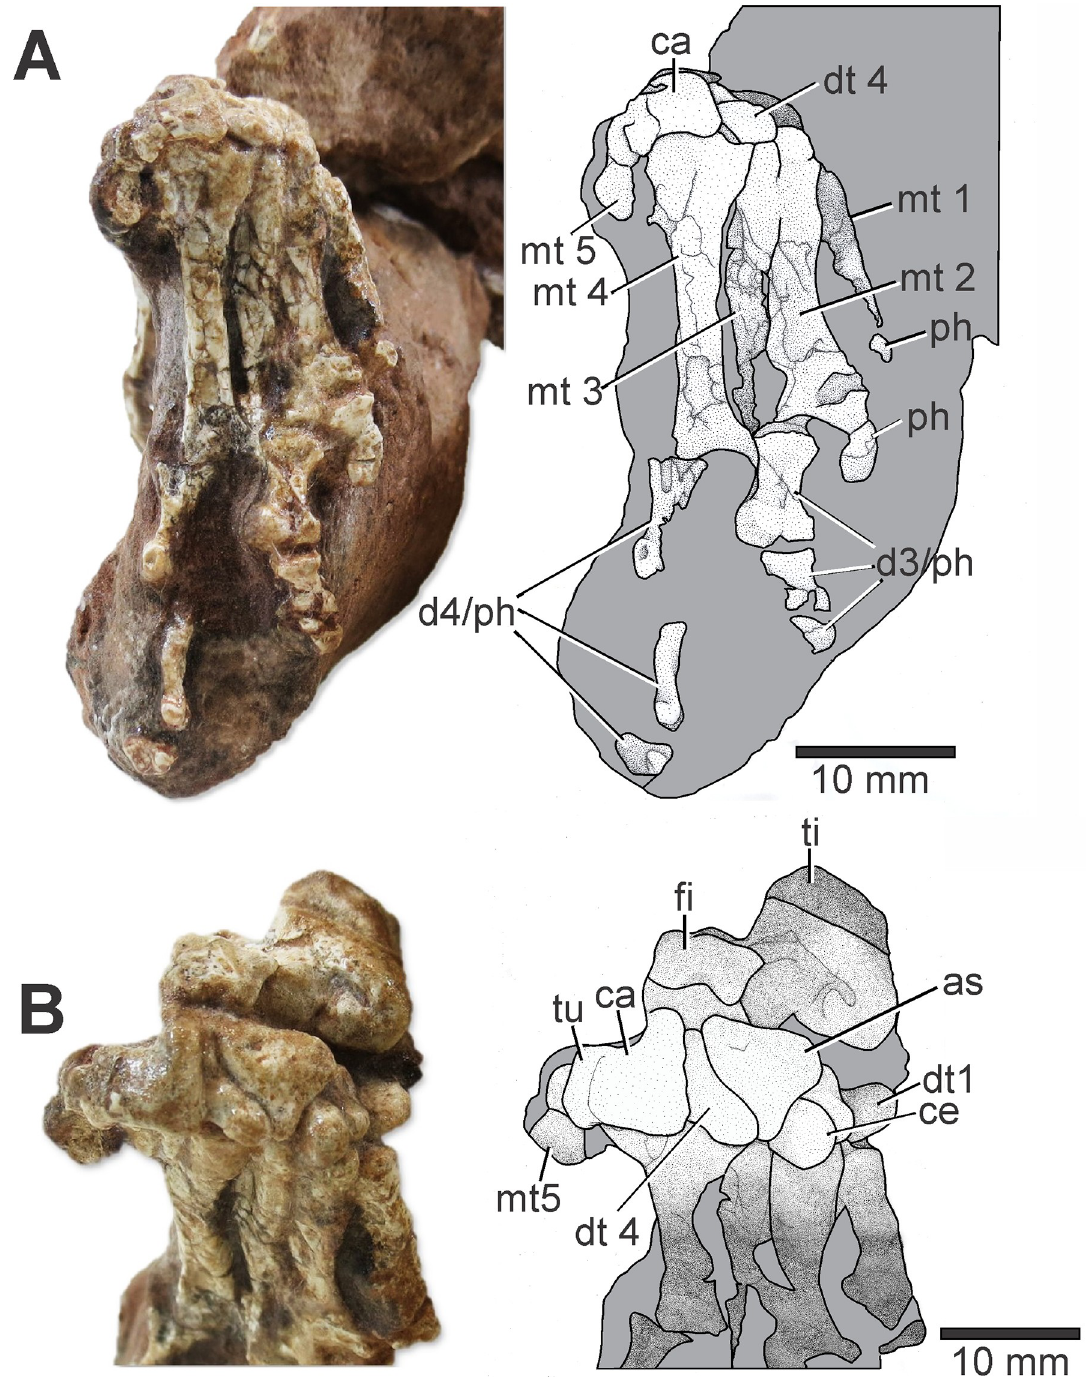
Fig 3. Plantar (A) and posteroplantar (B) views of the pes of Elessaurus gondwanoccidens (UFSM 11471) from the Sanga do Cabral Formation (Lower Triassic), Brazil. Photographs and explanatory drawings respectively. Abbreviations (A): ca, calcaneum; dt 4, distal tarsal 4; mt. metatarsal 1–5; d3—d4, digits; ph, phalange. (B) ti, tibia; fi, fıbula; ca, calcaneum; as. astragalus; tu, calcaneal tuber; mt, metatarsal 5; dt 1, distal tarsal 1; ce, centrale; dt 3, distal tarsal 3; dt 4, distal tarsal 4.